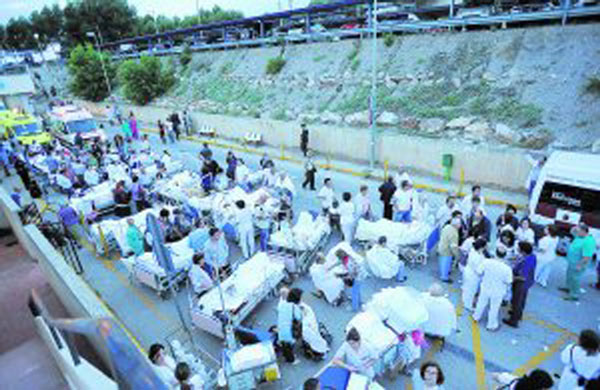
Hospital evacuation.